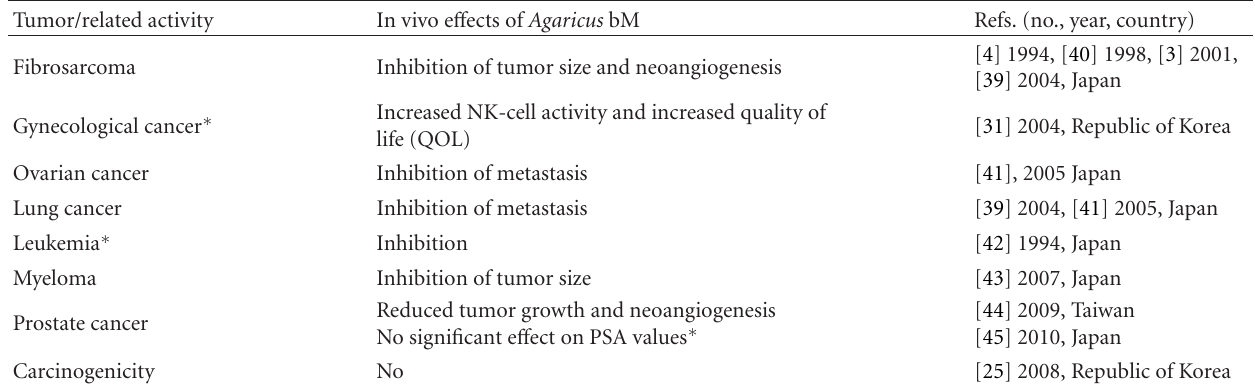
Table 1: Reported in vivo antitumor e ff ect of the mushroom Agaricus blazei Murill.